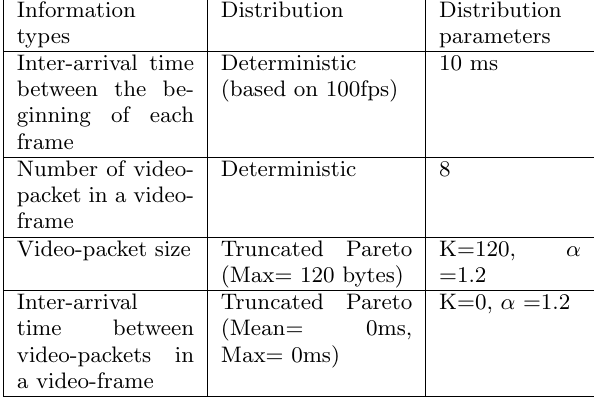
Table 1: Video traffic model